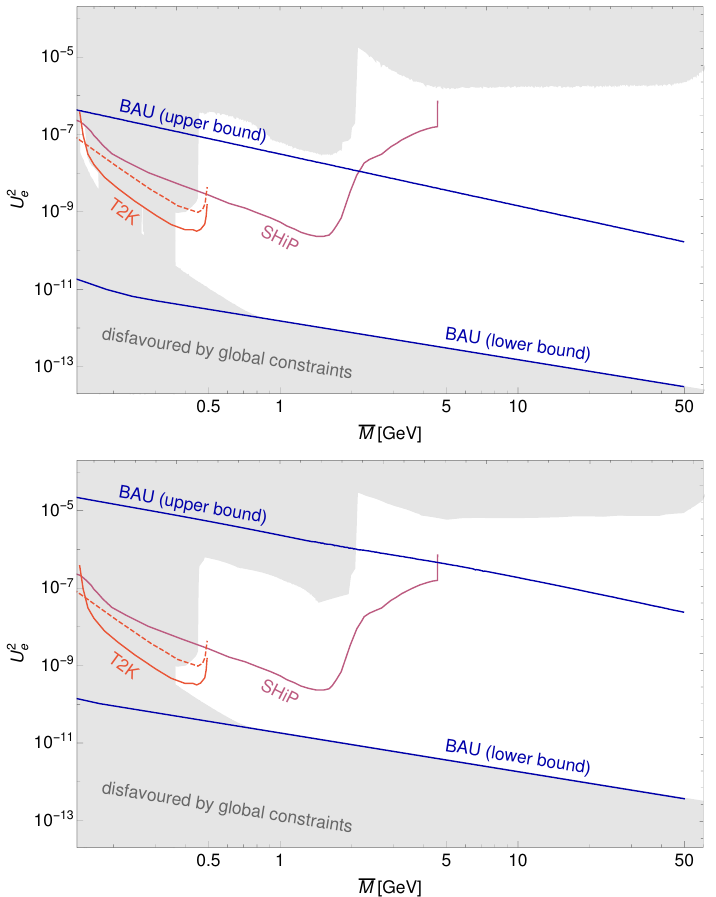
Figure 5 . Limits on U 2 as a function of (cid:22) M = ( M 1 + M 2 ) = 2 for normal hierarchy (top panel) e and inverted hierarchy (bottom panel). The grey area corresponds to the parameter region that is disfavoured by the combined constraints discussed in subsection 2.3. The dark blue lines are the upper and lower bound of U 2 consistent with neutrino oscillation data and the requirement to e account for the observed BAU. These are compared to the sensitivity of future experiments: the SHiP line (purple) show the 90% c.l. upper limits assuming 0 : 1 background events in 2 (cid:2) 10 20 proton target collisions for a ratio of U 2 : U 2 : U 2 (cid:24) 52 : 1 : 1 [166, 167]. The T2K e (cid:22) (cid:28)